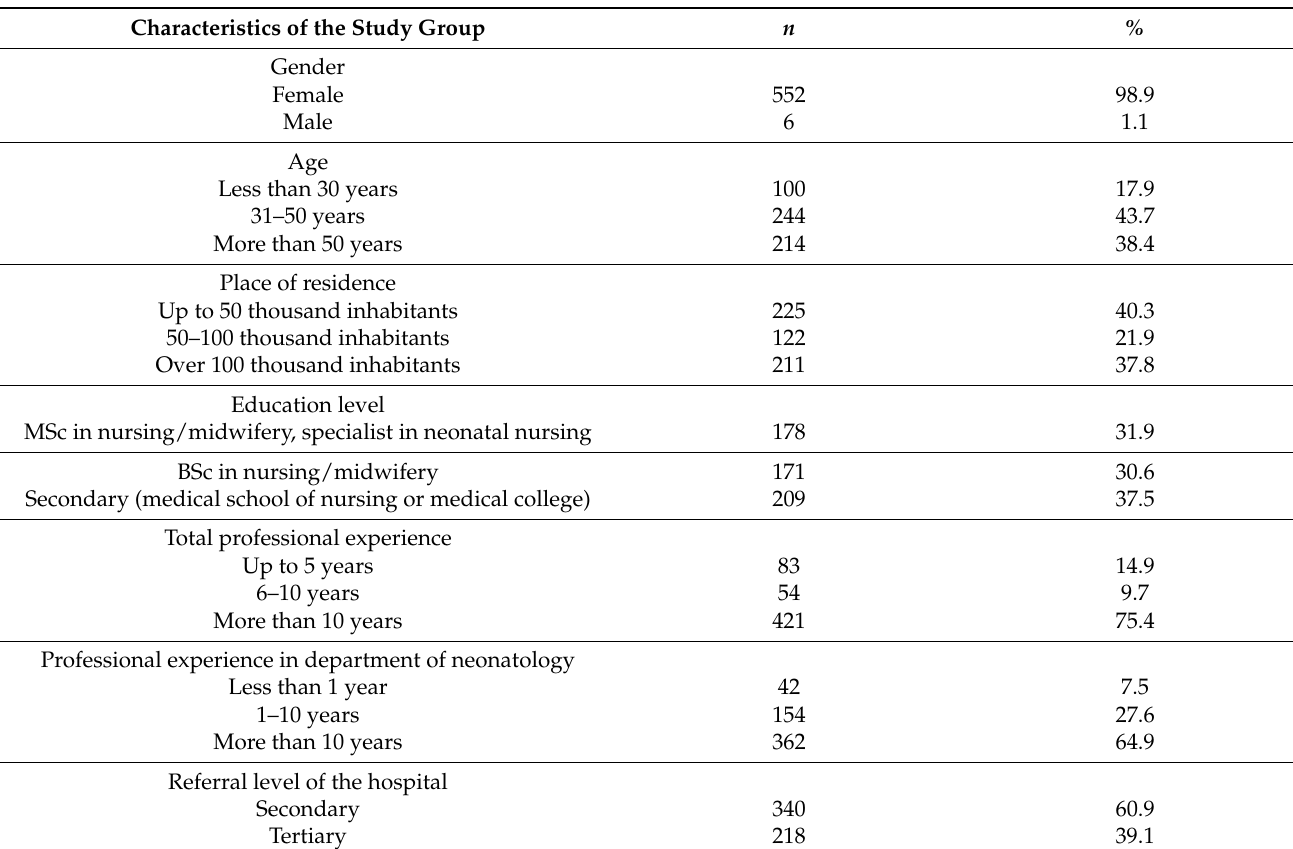
Table 1. Socio-demographic